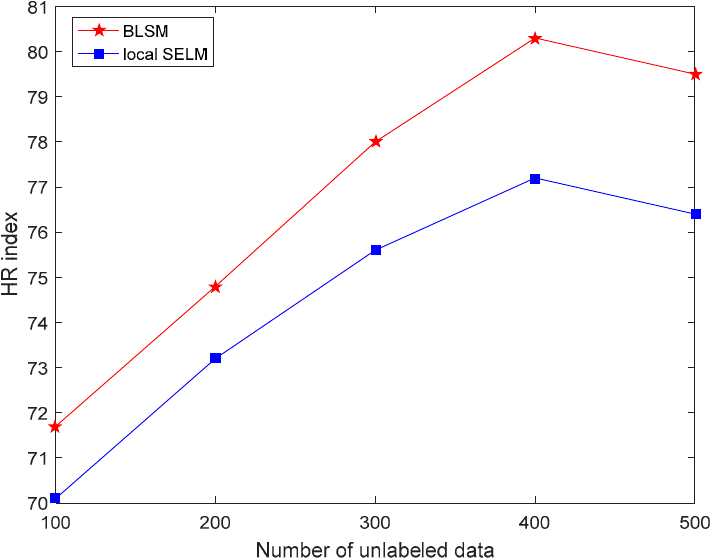
Figure 3. Relative RMSE (RE) comparison of the silicon content prediction between bagging local semi-supervised models (BLSM) and local semi-supervised extreme learning machine (SELM) models with different numbers of unlabeled data.